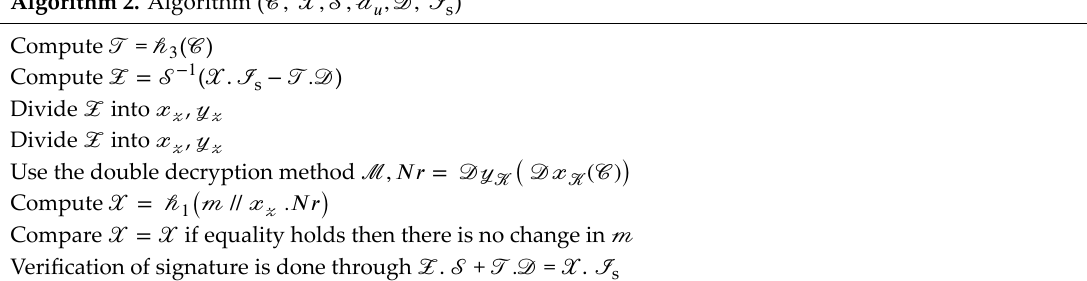
Algorithm 2. Algorithm ( 𝒞, 𝒳,𝒮,𝒹 𝑢 ,𝒟, ℐ s